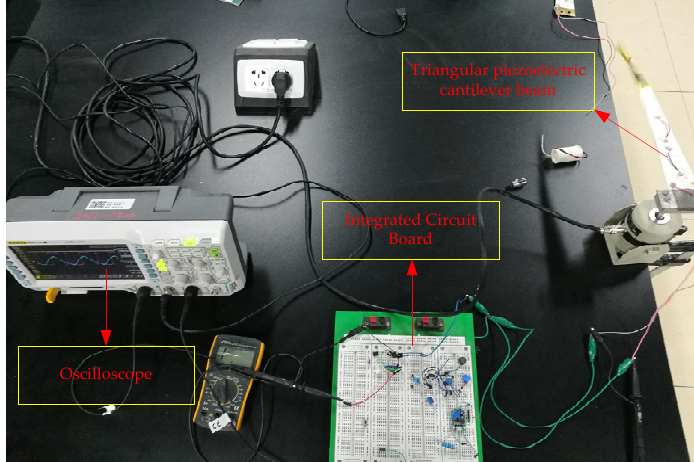
Figure 24. Power generation capacity test of triangular PCB.